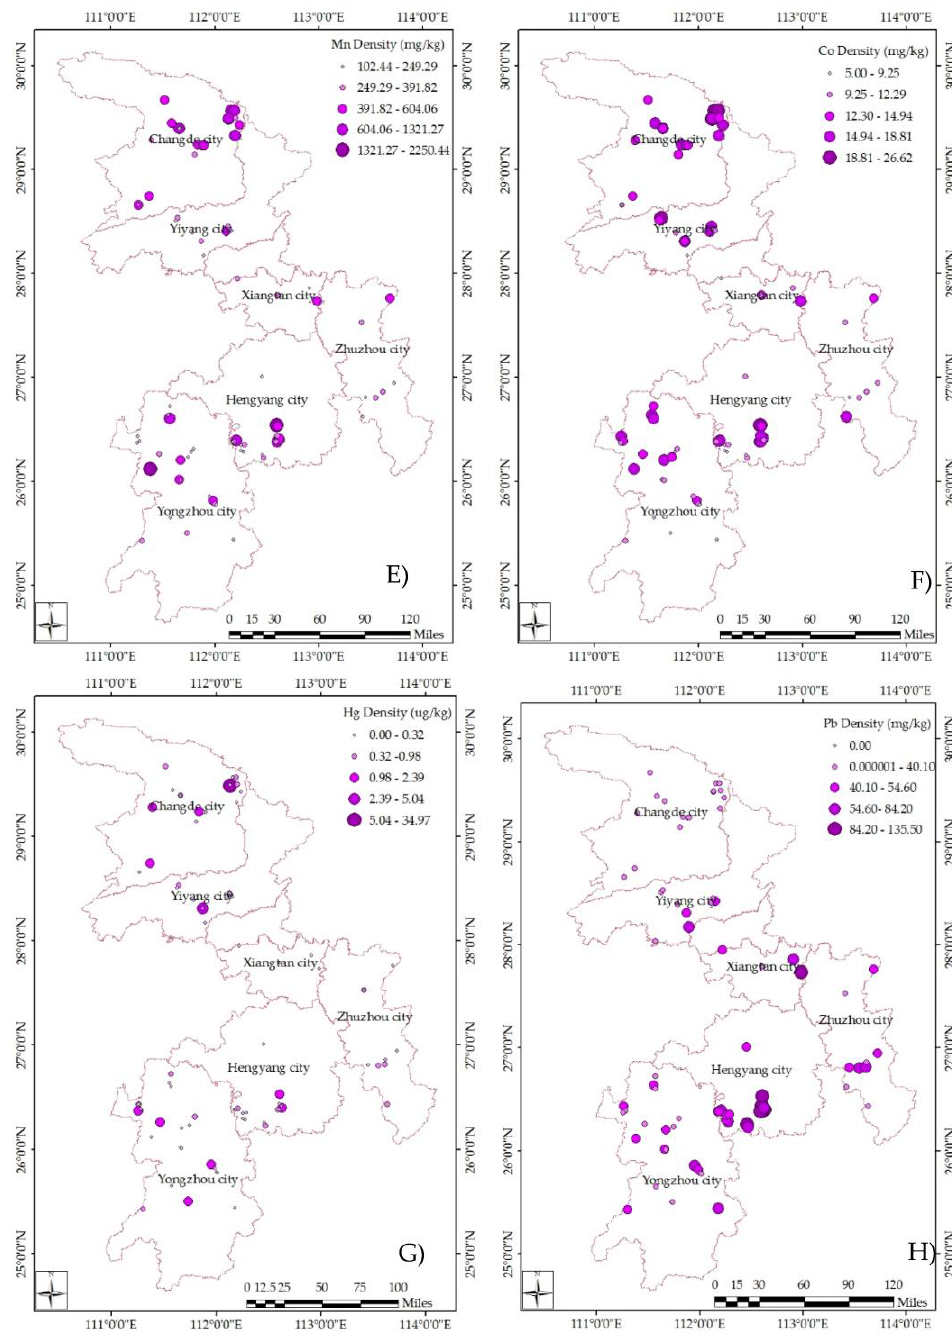
Figure 2. PTEs spatial distribution in the soil of six cities in Hunan based on 85 samples: ( A ) Cd, ( B ) Zn, ( C ) As, ( D ) Cu, ( E ) Mn, ( F ) Co, ( G ) Hg, and ( H ) Pb.